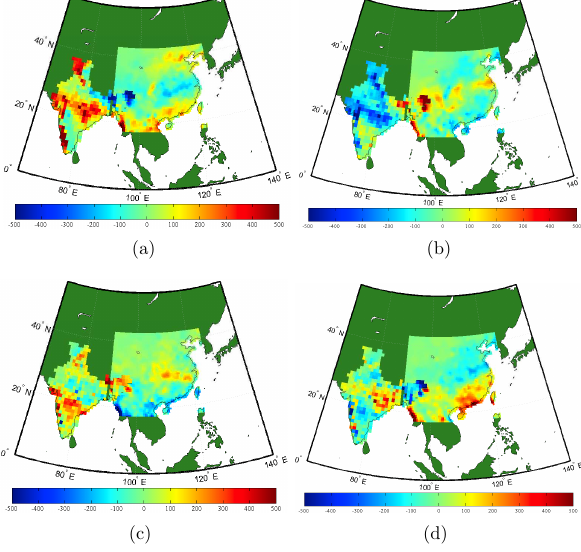
Fig. 6. Average rainfall anomaly in the monsoon months (JJAS) during five years with lowest or highest PCs values from Joint PCs. (a) Years with lowest PCs values from Joint PC1; (b) years with highest PCs values from Joint PC1; (c) years with lowest PCs values from Joint PC2; (d) years with highest PCs values from Joint